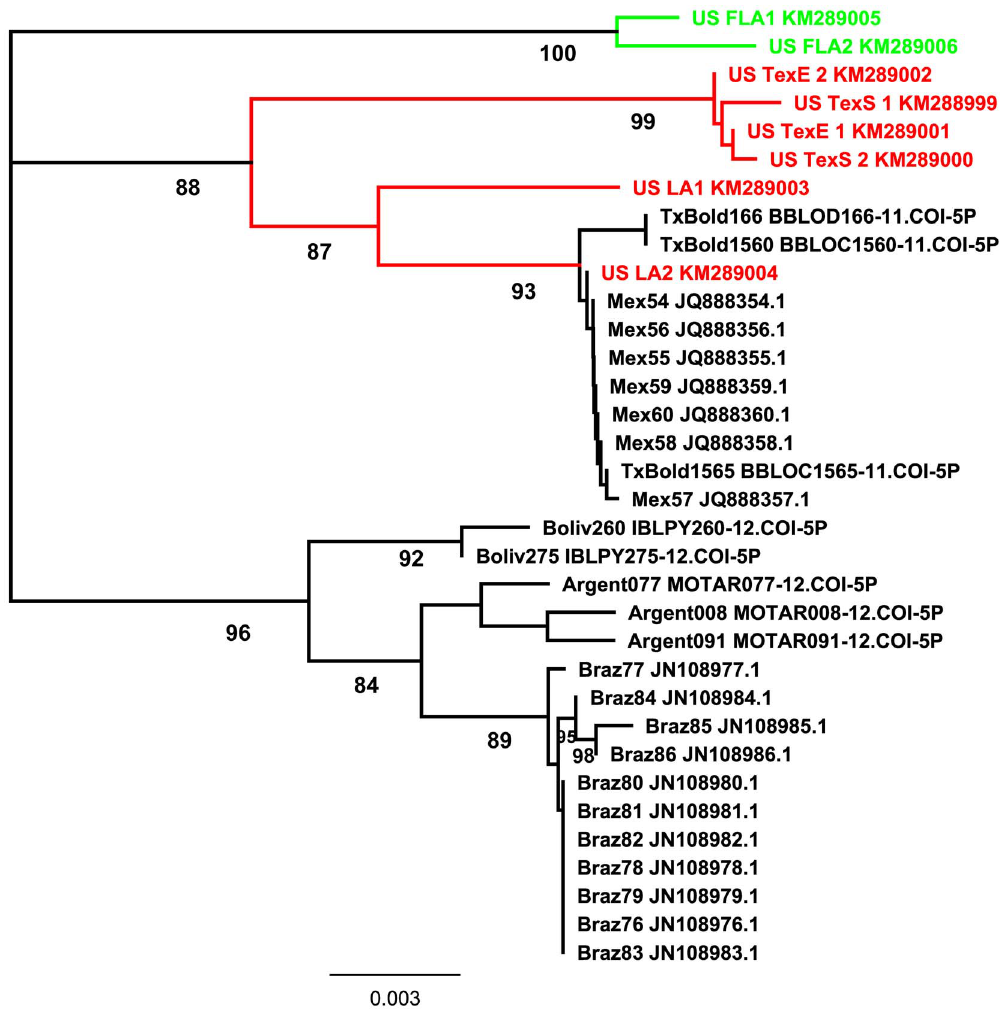
Figure 3. Neighbor joining phylogram of D.saccharalis populations. The phylogram is based on a neighbor joining analysis of 658 bp of the COI barcode region. Bootstrap support values are based on 500 pseudoreplicates, and those above 80% are shown below supported nodes. Individuals collected as part of this study are shown in color: Florida in green; Texas/Louisiana in red. Individuals shown in black were obtained from GenBank and BOLD databases. See Table 1 for specimen details.